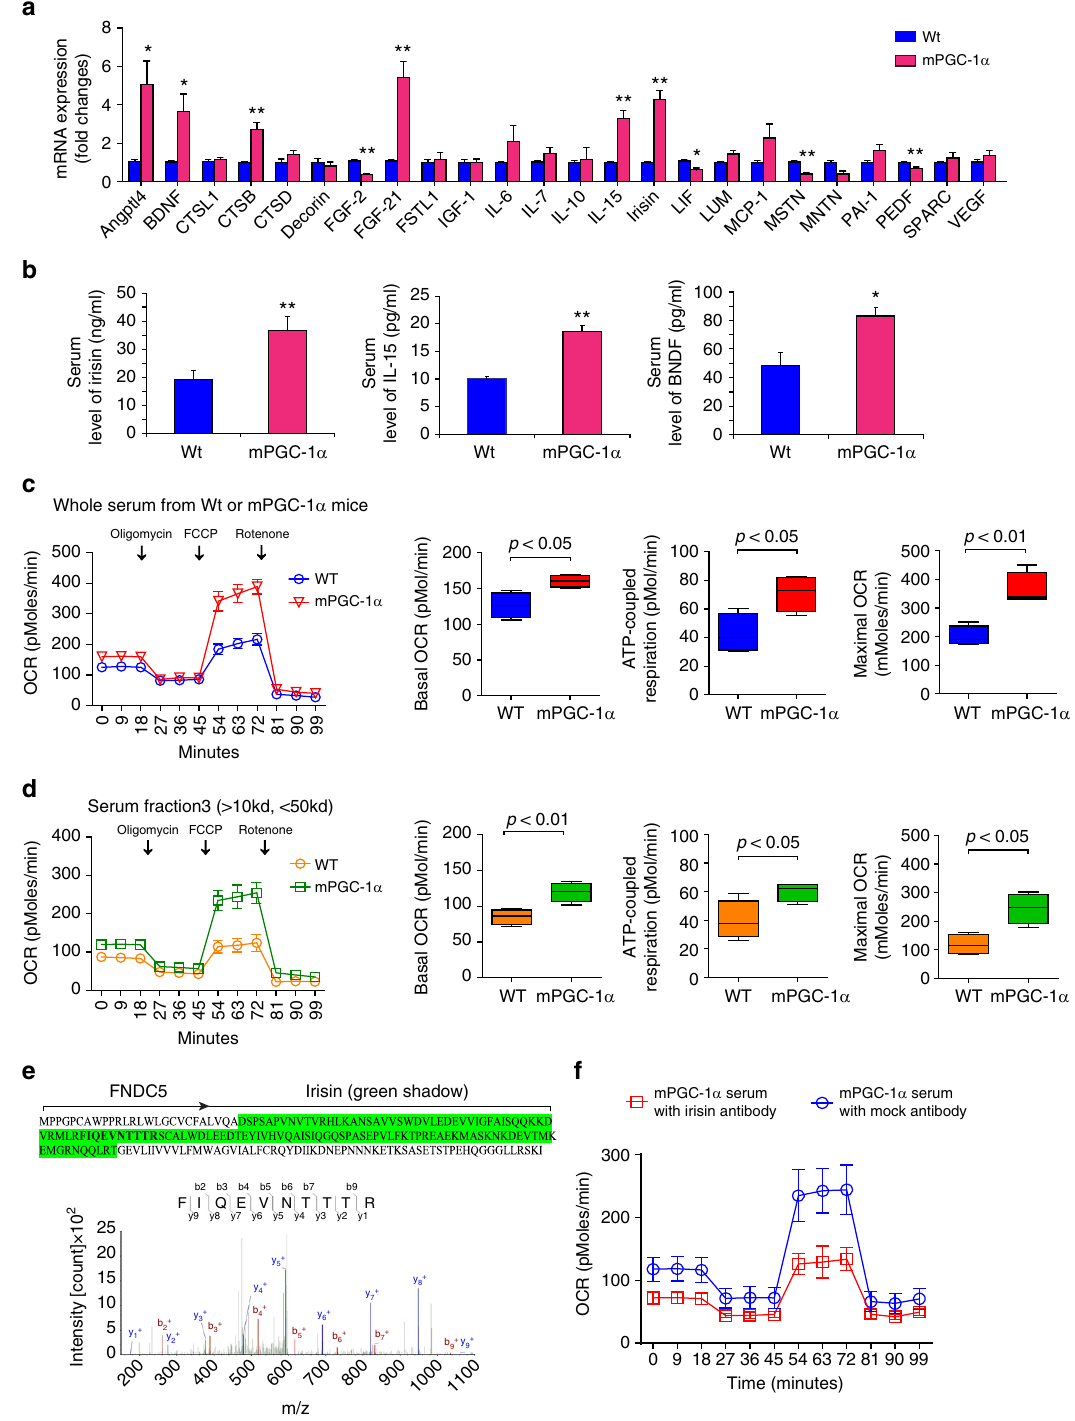
Fig. 4 Myokines in serum from mPGC-1 α mice stimulate tubular cell respiration. a Real-time qPCR analysis of 24 known myokines expression in skeletal muscles of Wt and mPGC-1 α mice. * P < 0.05 or ** P < 0.01 for mPGC-1 α vs. Wt mice ( n = 3 per group, Student-Newman-Kuel ’ s two-tailed, unpaired tests). b Serum concentration of selected myokines (irisin, iL-15 and BNDF) in Wt and PGC-1a mice. Data were presented as mean ± s.e.m.; * P < 0.05 or ** P < 0.01 for mPGC-1 α vs. Wt mice ( n = 5 per group; Student-Newman-Kuel ’ s two-tailed, unpaired tests). c Primary tubule cell cultures were incubated with 10% of serum form WT or PGC-1 α mice for 12 h followed by cellular respiration measurement. Measurements of basal OCR, ATP-coupled respiration and maximal respiration in each group ( n = 5 per group, Student-Newman-Kuel ’ s two-tailed, unpaired tests). d Primary tubule cell cultures were treated with different serum fractions, only serum fraction 3 ( < 50 kd, but > 10 kd) exhibited a signi fi cant increase in cell respiration ( n = 5 per group, Student-Newman-Kuel ’ s two-tailed, unpaired tests). e In serum fraction 3, the present of irisin was con fi rmed by mass spectra. f Sera from mPGC-1 α mice was incubated anti-irisin antibody or mock antibody for 4 h and following with an incubation with protein A/G for 1 h at 4 °C. After spindown to remove irisin and lgG, the sera were used to treat primary cultured tubule cells following a measurement of cellular